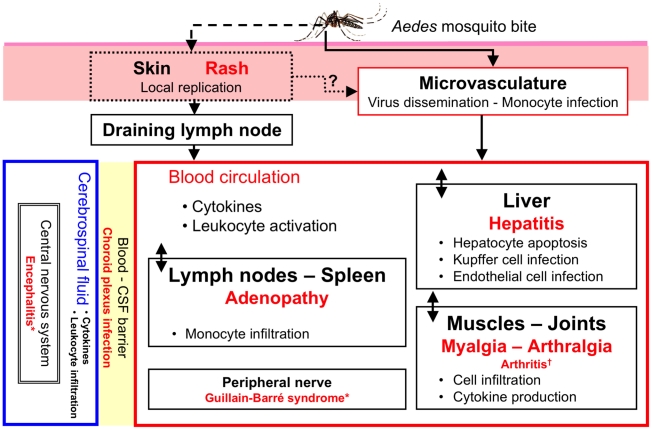
Virus dissemination and target organs.Following inoculation with CHIKV through a mosquito bite, the virus directly enters the subcutaneous capillaries, with some viruses infecting susceptible cells in the skin, such as macrophages or fibroblasts and endothelial cells. Local viral replication seems to be minor and limited in time, with the locally produced virus probably being transported to secondary lymphoid organs close to the site of inoculation. The blood carries most viruses, as free virions or in the form of infected monocytes, to the target organs, the liver, muscle, joints, and remote lymphoid organs. In these tissues, infection is associated with a marked infiltration of mononuclear cells, including macrophages, particularly when viral replication occurs. The pathological events associated with tissue infection are mostly subclinical in the liver (hepatocyte apoptosis) and lymphoid organs (adenopathy), whereas mononuclear cell infiltration and viral replication in the muscles and joints are associated with very strong pain, with some of the patients presenting arthritis. * Guillain-Barré syndrome and encephalitis are very rare events. † True arthritis remains a rare event (from 2% to 10%); see Table 2.